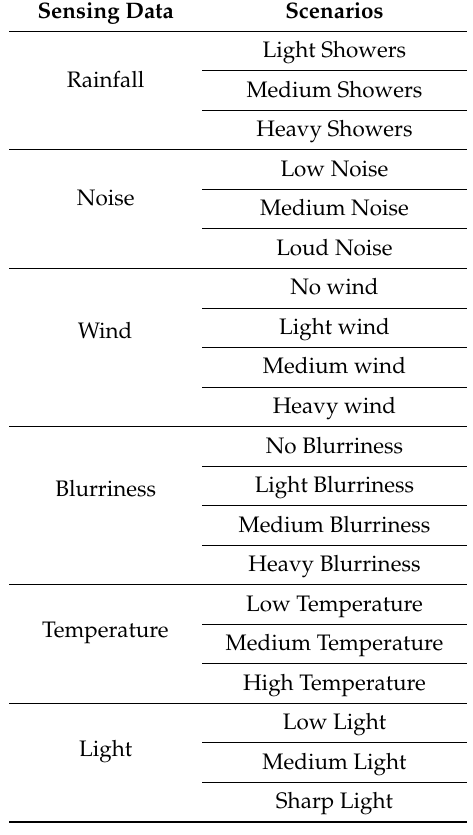
Table 2. Environment sensing data scenario classification for building rules.